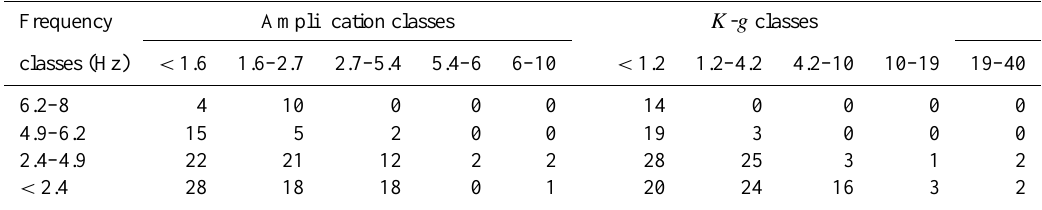
Figure 8. Data classification based on the C – A method: (a) frequency, (b) amplification, (c) K - g value. Table 5. Frequency of amplification and K - g classes in every frequency